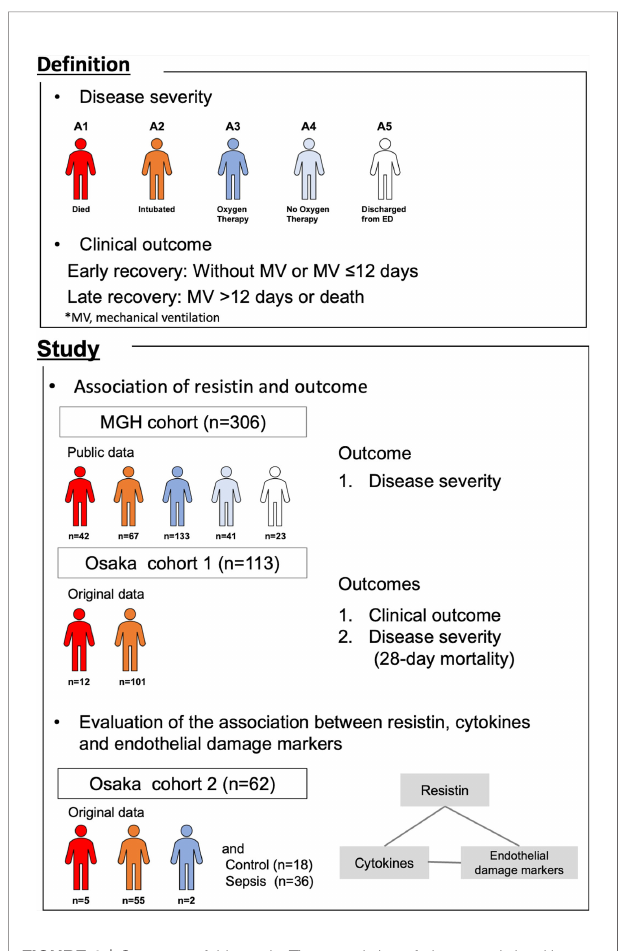
FIGURE 1 | Summary of this study. The association of plasma resistin with outcome was evaluated in the MGH cohort and Osaka cohort 1. The association between resistin, cytokines and endothelial cell adhesion molecules was evaluated in Osaka cohort 2. MGH, Massachusetts General Hospital; MV, mechanical